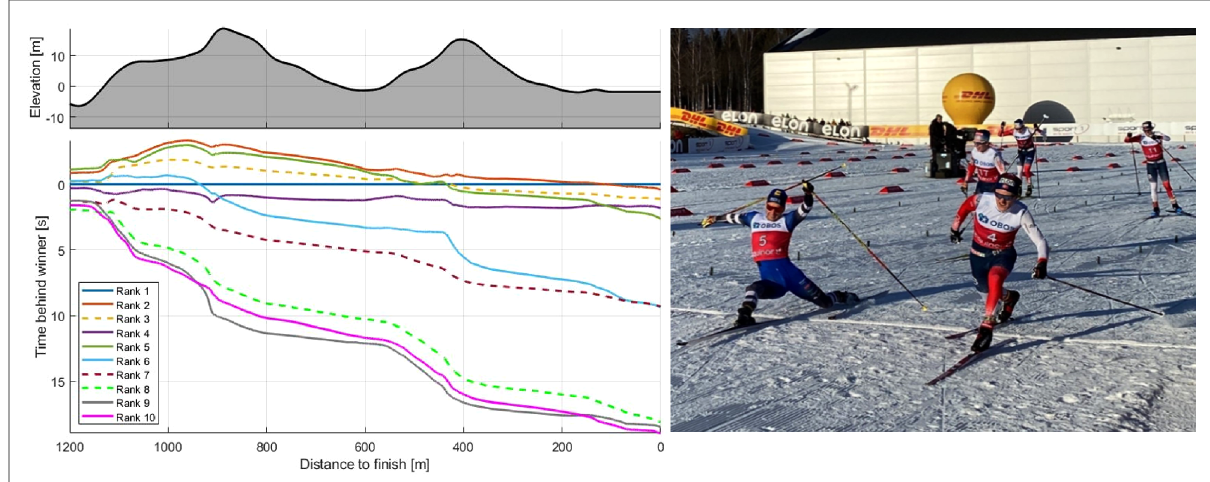
FIGURE 9 Time behind winner [s] for the top 10 skiers during the last 1.2 km of a 21.8 km mass-start competition (left) and picture of the two best skiers crossing the fi nish-line (right). Skier with fi nal ranks 3, 7 and 8 have synthetic speed pro fi les derived from a deep learning model described in detail in the